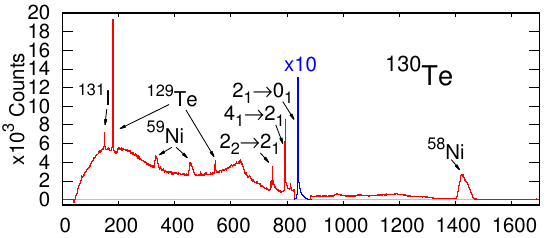
Figure 1. Energy spectrum taken at 65 ◦ in Run F as defined in Table 1 (enriched 130 Te target). The decay of the first excited state has been scaled down by a factor of 10.